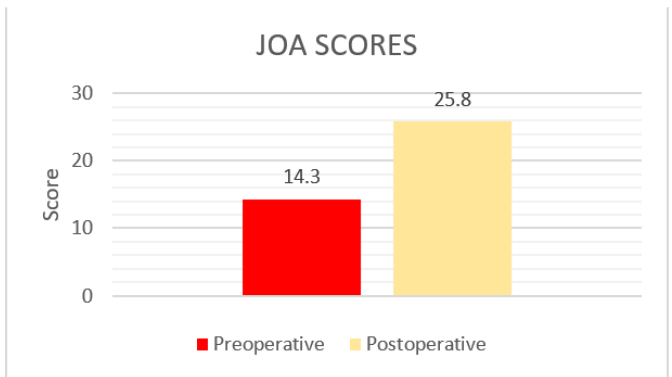
Figure 3. The Japanese Orthopaedic Association (JOA) scores pre and postoperatively.